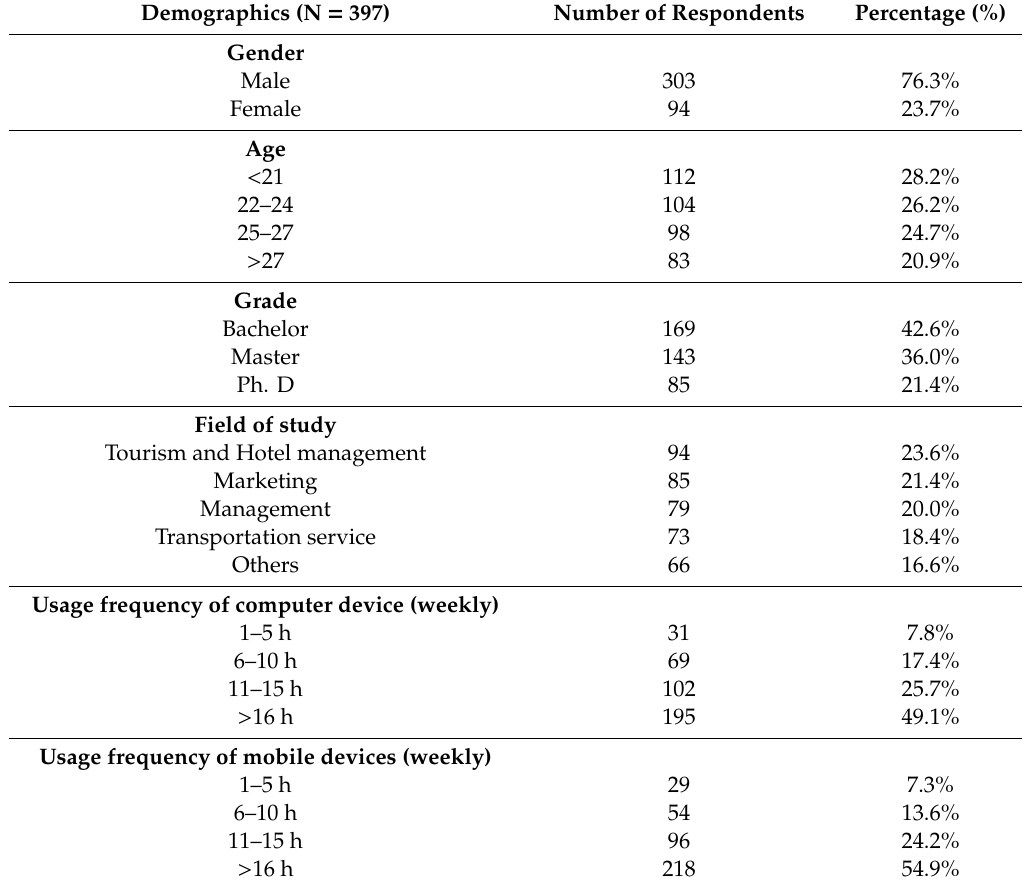
Table 3. Demographic information of